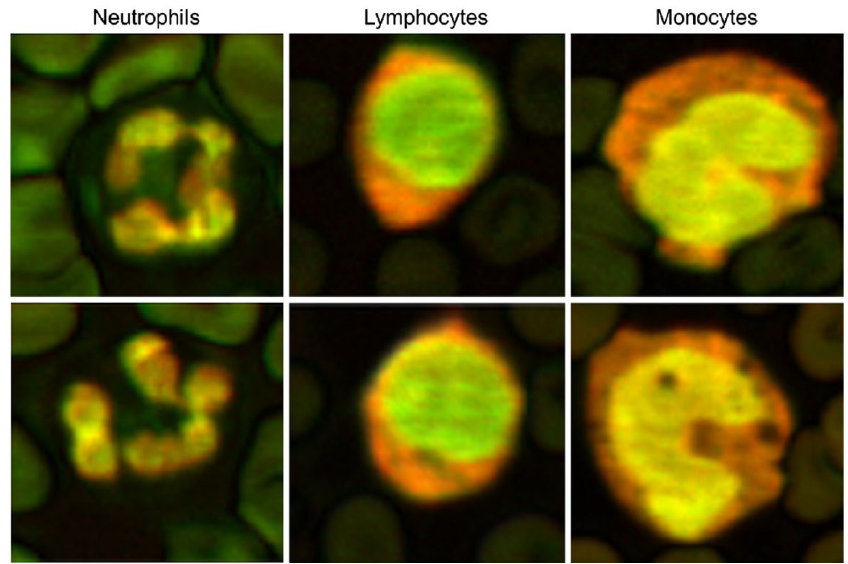
Figure 20. Composite photoacoustic images of the neutrophils, lymphocytes, and monocytes created by merging 532 and 600 nm photoacoustic images. Reprinted from Strohm et al., Photoacoustics, 2016, 4, 1: 36–42 [38], with permission of Elsevier.